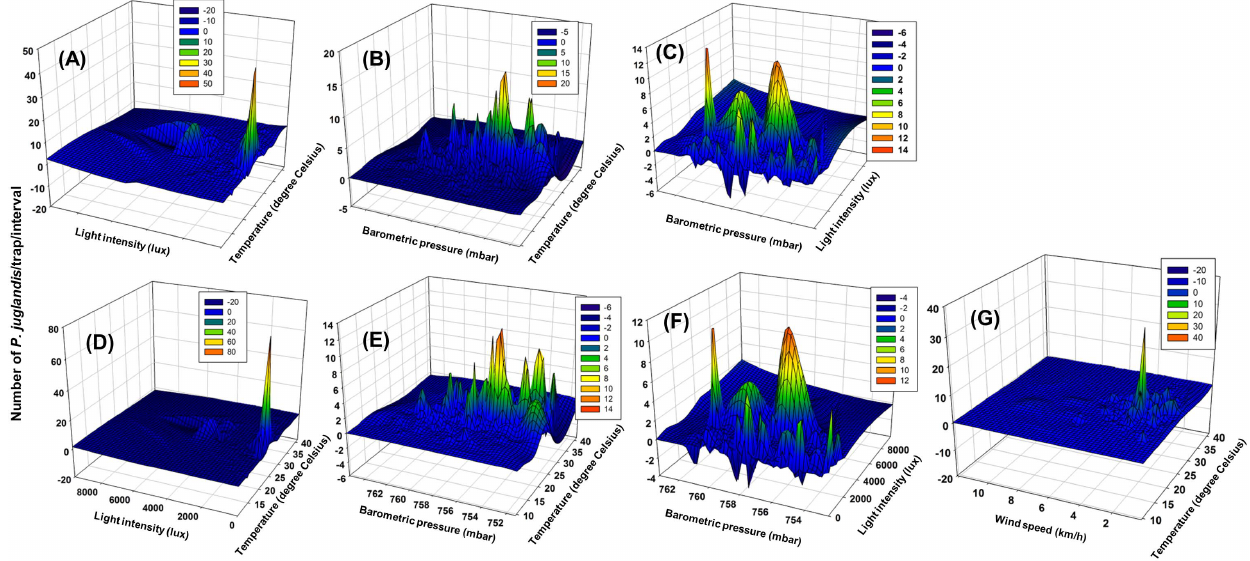
Figure 9. Second-order interactions of abiotic factors on Pityophthorusjuglandis trap catches. (A) Temperature and light intensity (male); (B) Temperature and barometric pressure (male); (C) Light intensity and barometric pressure (male); (D) Temperature and light intensity (female); (E) Temperature and barometric pressure (female); (F) Light intensity and barometric pressure (female); and (G) Temperature and wind speed (female). doi:10.1371/journal.pone.0105945.g009 PLOS ONE |